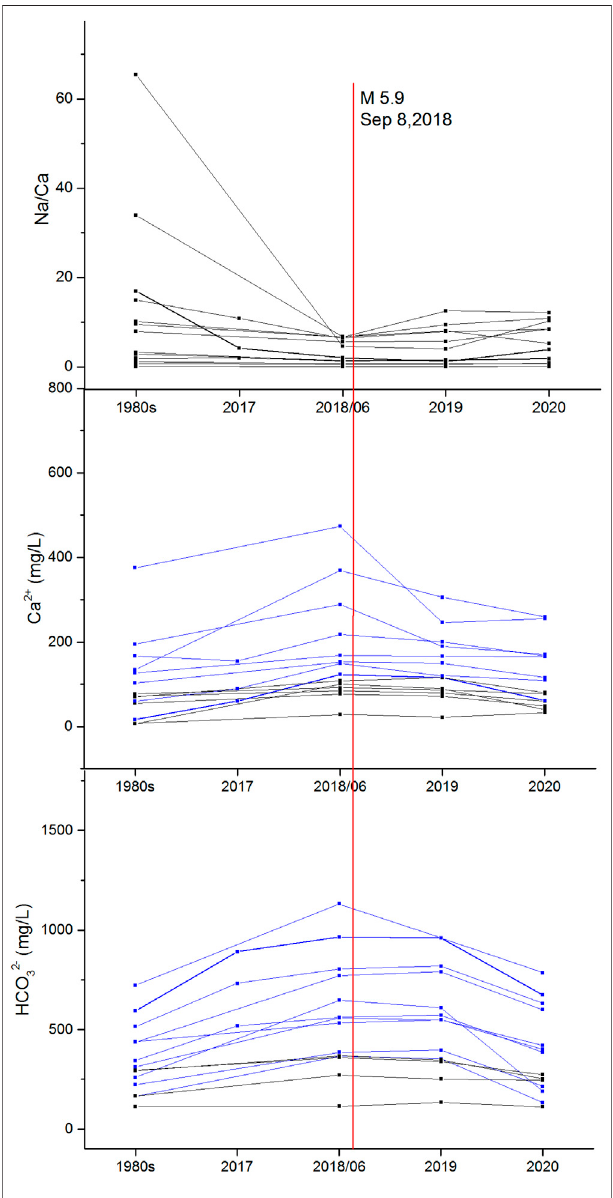
FIGURE 4 | Hydrogeochemical changes of thermal springs from the 1980s to 2020.